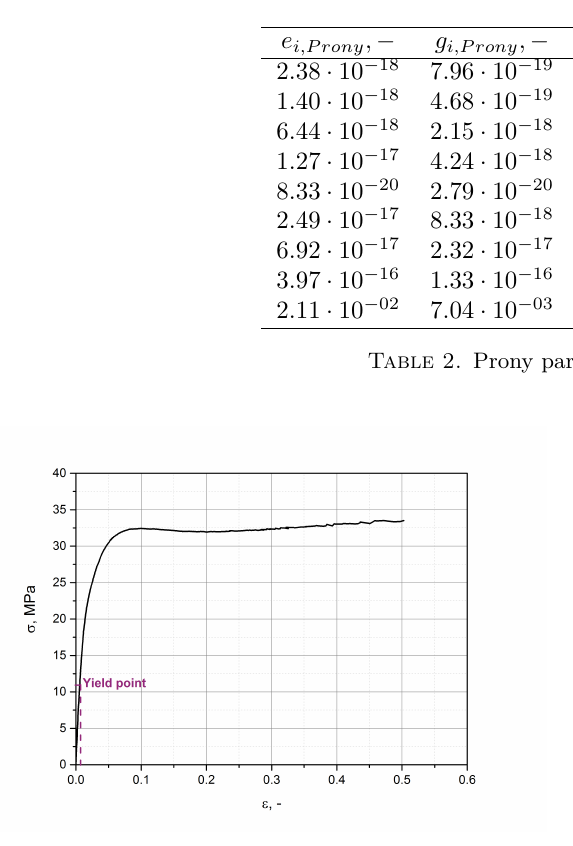
Figure 10. Experimental data for elasto-plastic ma- terial model: PP(H).